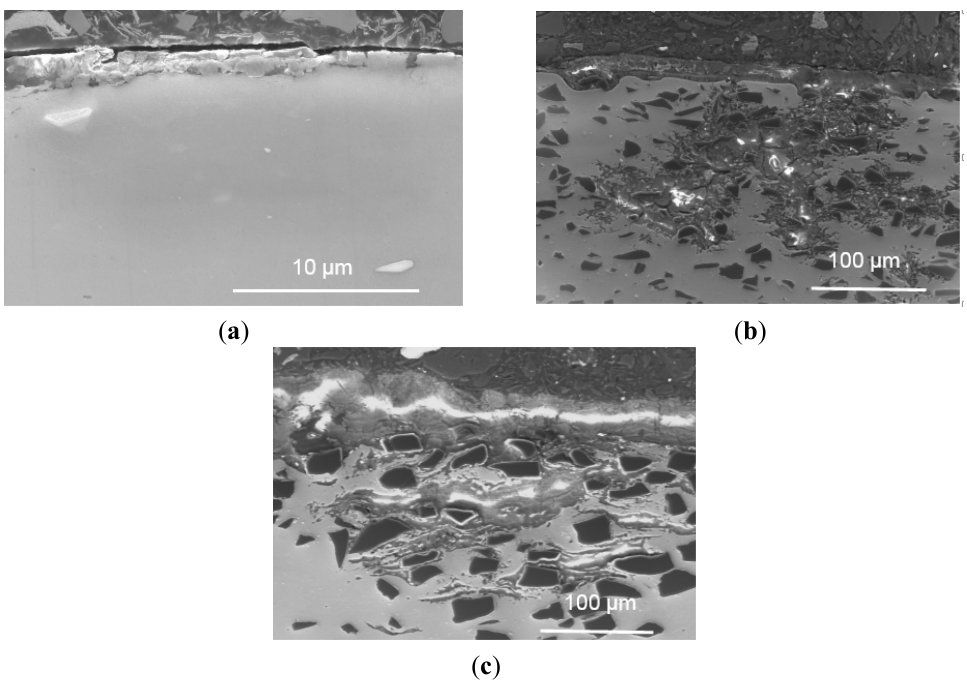
Figure 11. Cross-sectional morphology of ( a ) AA1100; ( b ) AA1100-16 vol.% B 4 C and ( c ) AA1100-30 vol.% B 4 C specimen immersed in 3.5 wt.% NaCl solution for 10 days.